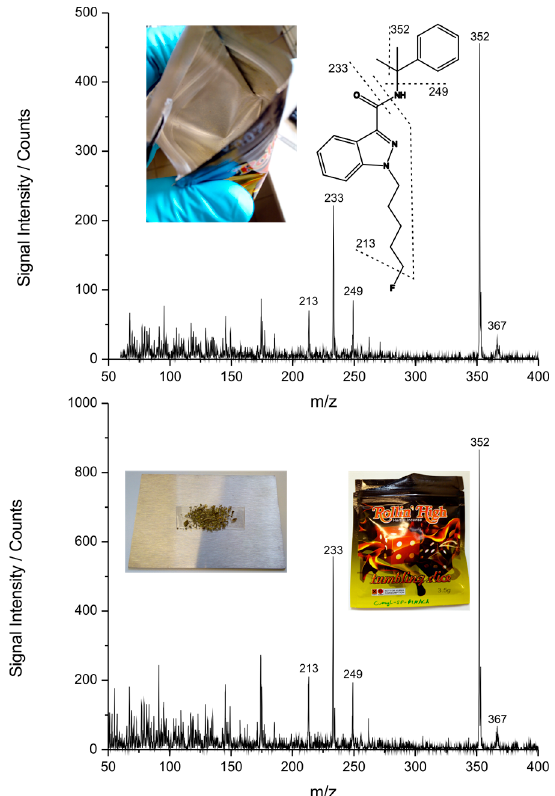
Figure 4. APLD EI-mass spectra of the herbal blend material. Direct laser desorption exhibits intense signals at higher m / z , tentatively assigned to 5F-Cumyl-PINACA from an herbal blend sold as “Rollin’ High”. This new psychoactive substance could be detected directly from herbal blend as well as residues sticking on the bag. The upper part shows a mass spectrum achieved by desorbing the inner side of the bag and the lower one a direct measurement of the herbal blend. A similar spectrum compared to the inside of the empty bag is revealed.